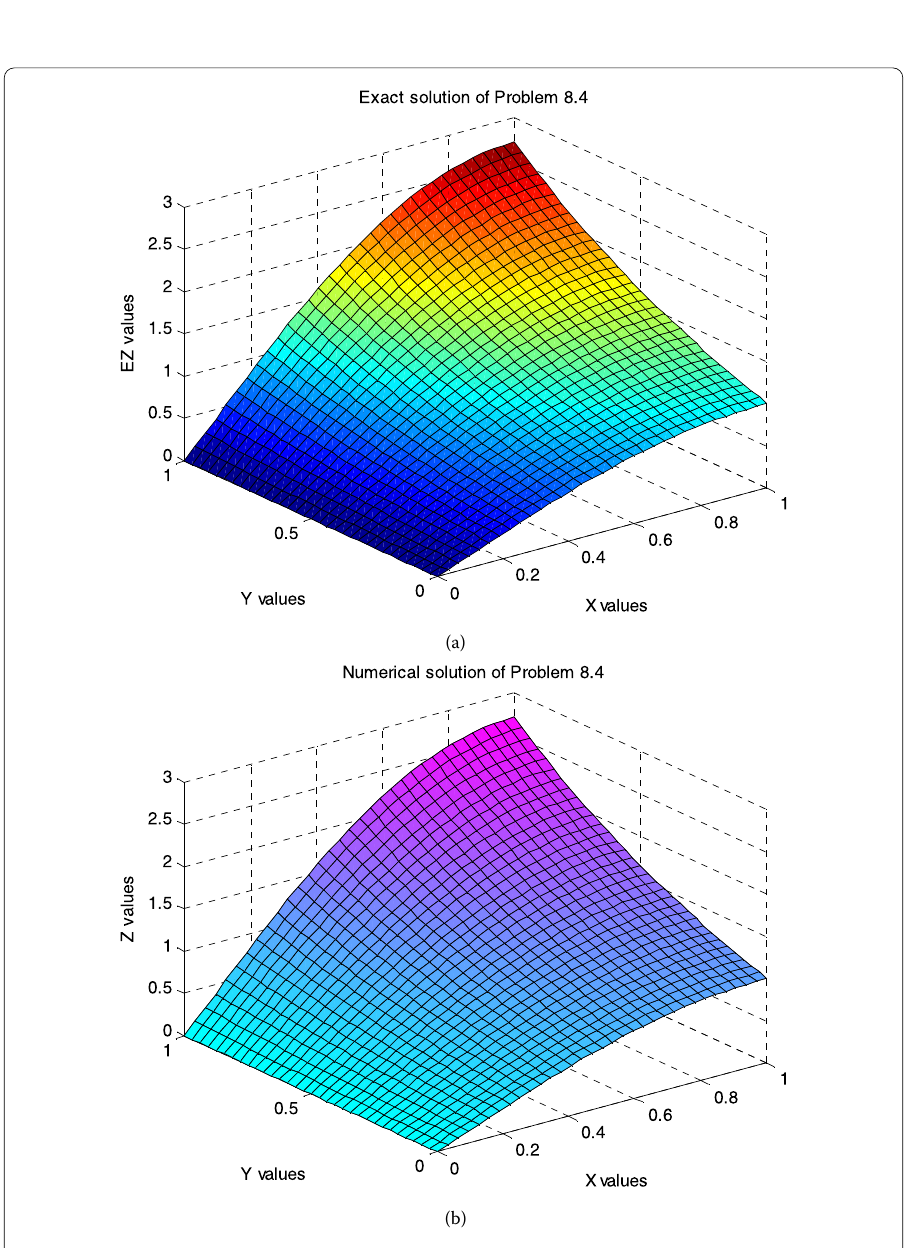
Figure 5 ( a ) Exact solution of Problem 8.4 for h = 1/32 and ε = 0.01. ( b ) Numerical solution of Problem 8.4 for h = 1/32 and ε =